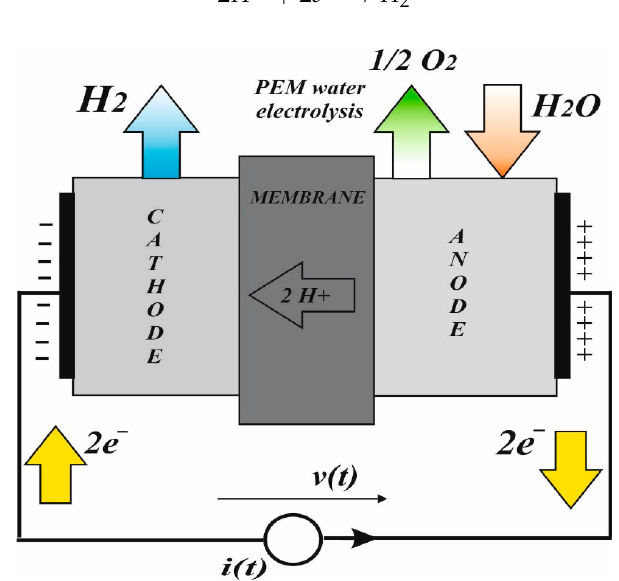
Figure 1. Proton exchange membrane (PEM) water electrolysis reactions. In the anode, the water is divided into protons and oxygen providing electrons; in the cathode, the protons combine with electrons coming from the terminal at negative potential, obtaining hydrogen.